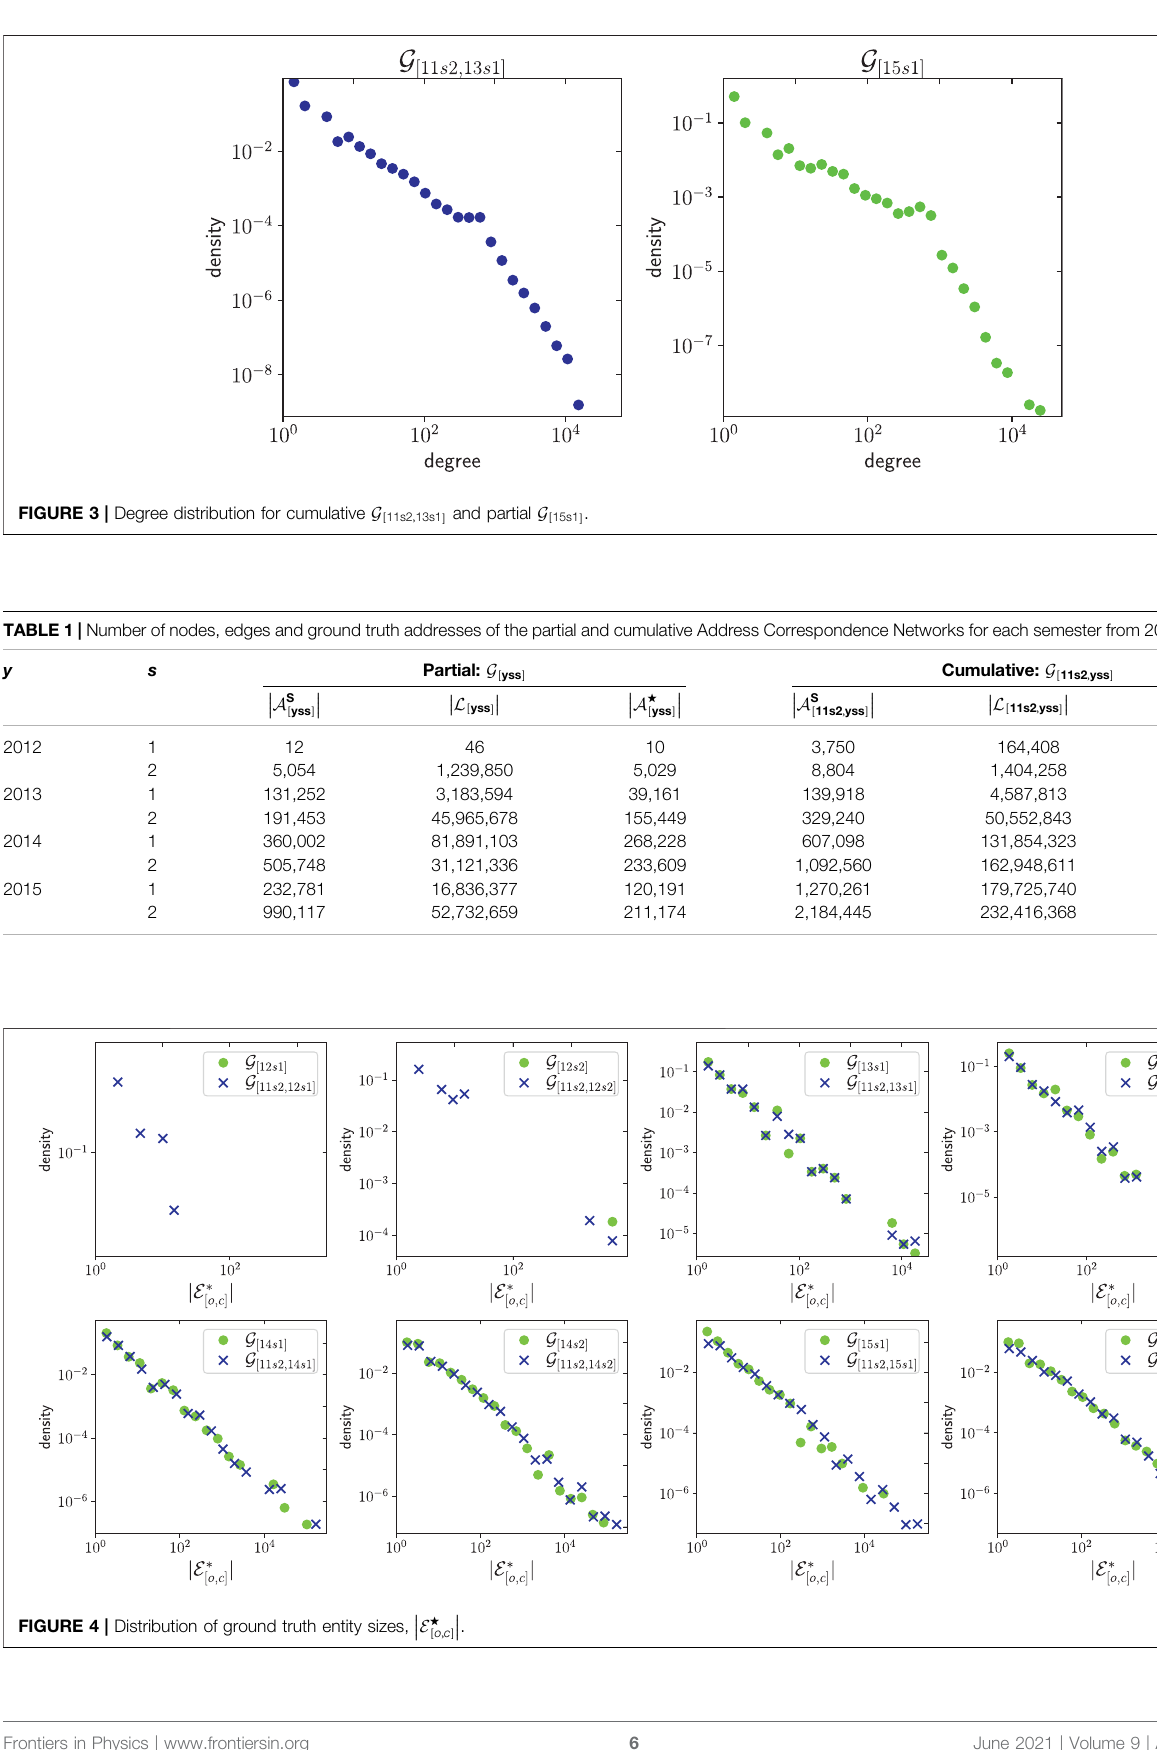
Frontiers in Physics |